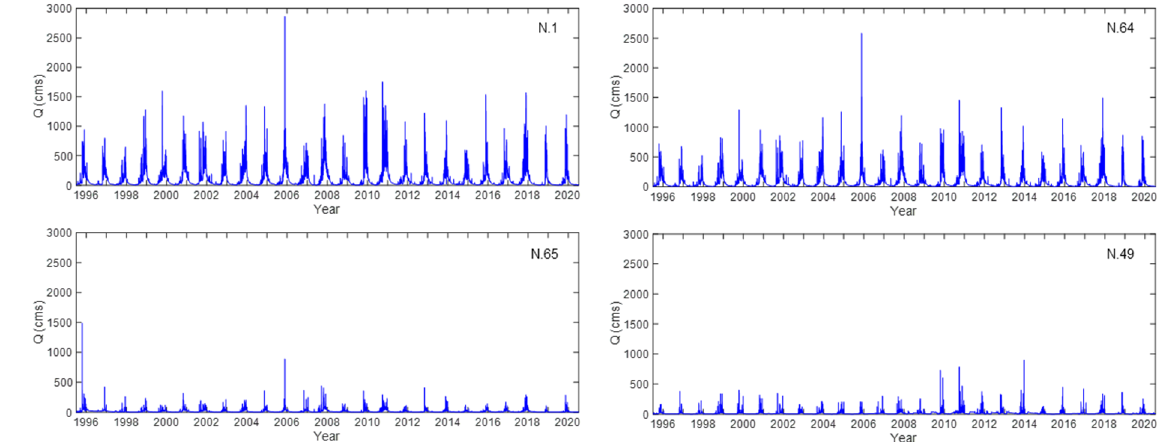
Figure 3. Discharge data collected from stations located in the Upper Nan river basin.